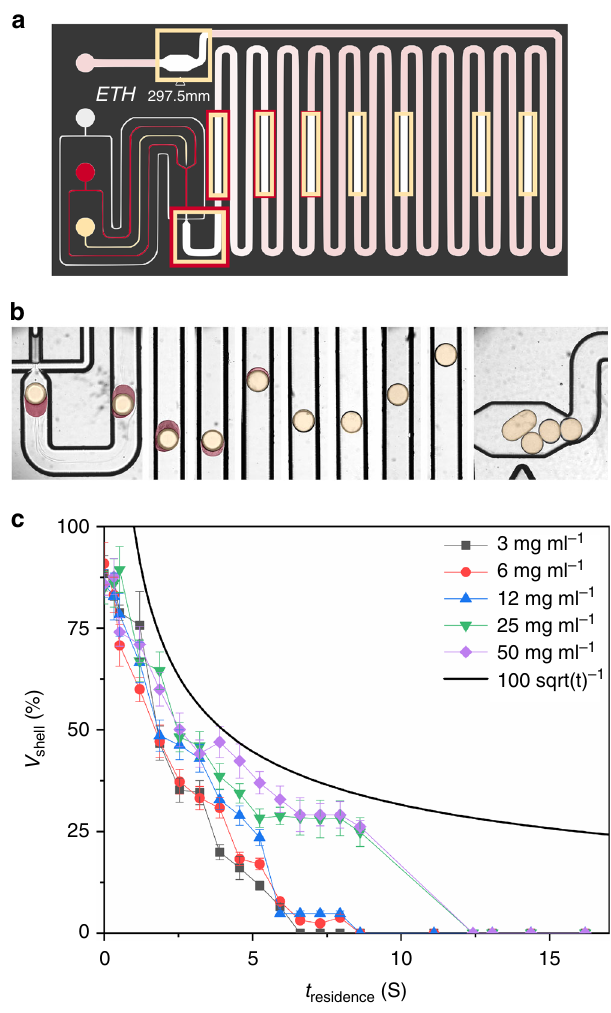
Fig. 2 Transient double emulsions. a Micro fl uidic chip with the inlets for the outer (white), middle (red), and inner (beige) phases, indicating positions where droplets were imaged. b Transient droplets as imaged in different positions along the channel (indicated in a ) for a system as in Fig. 1 (false coloured for clarity) with a particle concentration of 12 mg ml − 1. c Quanti fi cation of the middle droplet phase volume as a function of residence time in the channel, for different particle loadings in the middle phase. The error bars in c represent the standard deviation of the